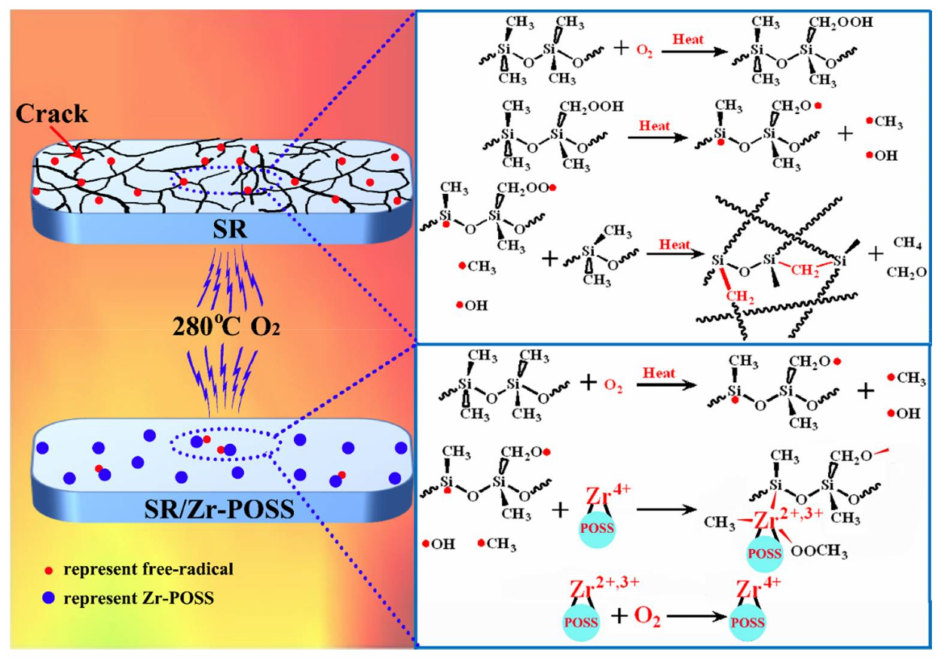
Figure 12. Possible mechanism of Zr-POSS on improving the thermal-oxidative aging properties of